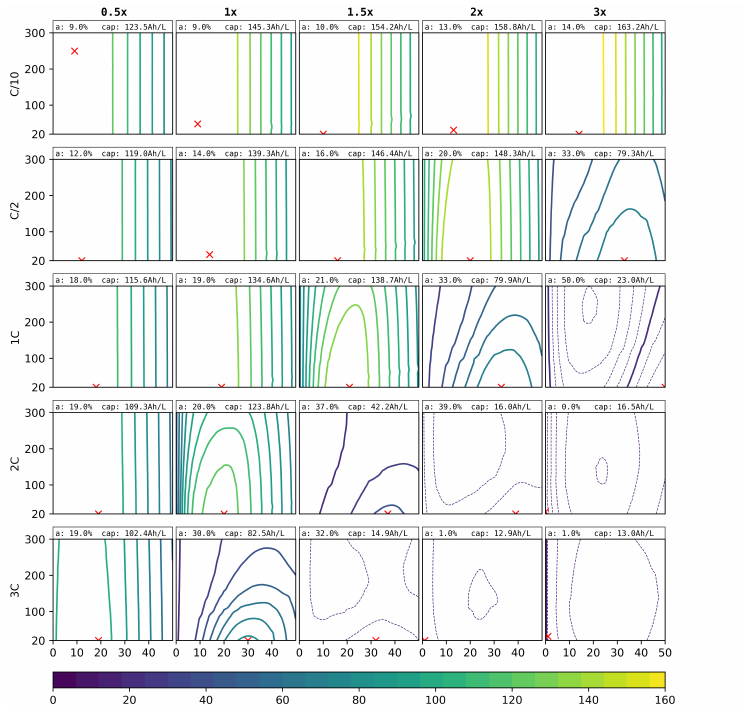
Figure 10. Simulated discharge capacity (Ah) for different C-rates (outer y-axis), laser pitches ((µm), inner y-axis), thicknesses (outer x-axis), and degrees of ablation ((%), inner x-axis). The red crosses show the optimal degrees of ablation and pitch for each C-rate and structuring method. The optimal parameters and the respective discharge capacity are indicated at the top of each graph. Solid lines differ by 10Ah/L and dashed lines by